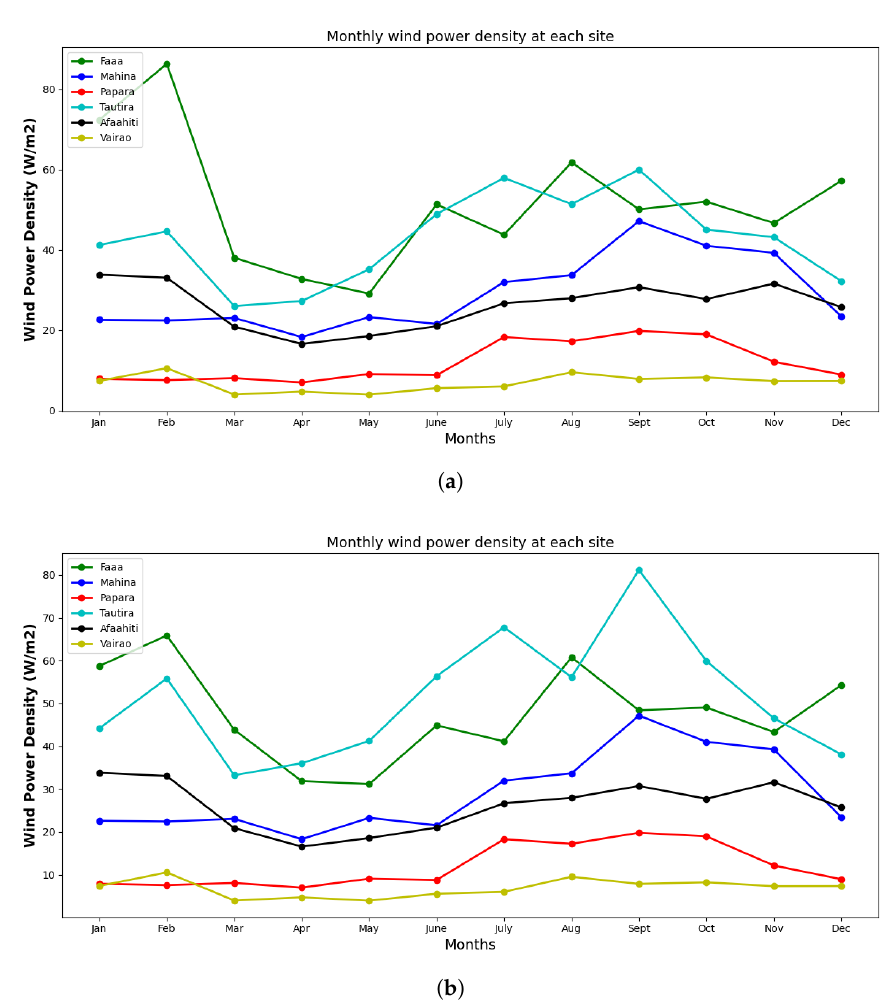
Figure 6. Monthly variation in 10 m WPD. ( a ) Monthly WPD considering the 2016–2020 period for all stations. ( b ) Monthly WPD considering the 2016–2020 period for four stations and 2008–2020 for Faaa and